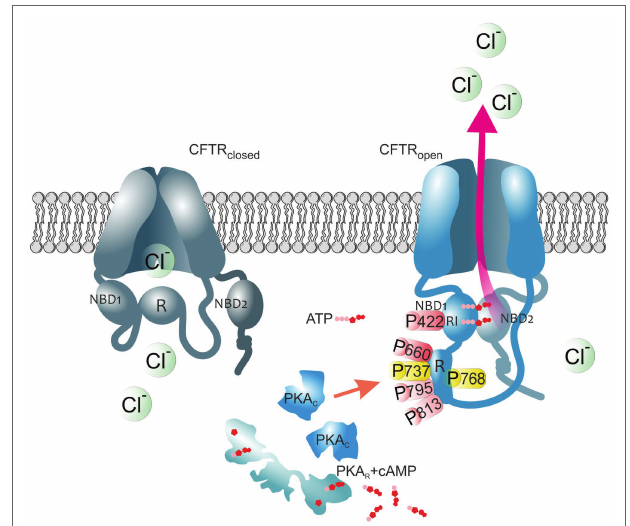
FIGURE 1 | The impact of PKA-mediated phosphorylation on CFTR channel. The cystic fibrosis transmembrane conductance regulator (CFTR) structure consists of two membrane spanning domains, two nucleotide-binding domains (NBD1 and NBD2), and the unique cytoplasmic regulatory (R) domain. Among these, the latter represents a critical site of channel regulation due to its enrichment in protein kinase A (PKA) consensus motifs, with multiple serines and threonines as phosphorylation targets. Moreover, there is an additional phosphorylation site in the regulatory insertion (RI) segment of NBD1. In the closed CFTR state (left channel), the NBD1 interacts with the R domain creating steric hindrances which prevent it from dimerization with NBD2. Upon PKA- dependent phosphorylation (right channel), large conformational changes occur that decrease this interaction leading to the release of the R region from its inhibitory position and allow NBDs dimerization, ultimately ATP binding and CFTR-mediated chloride secretion. Thus, the open probability of the channel is dependent on the access of PKA to the main phospho-sites (S422, S660, S737, S768, S795, and S813). Phospho-sites critical for CFTR channel activation are shown in red. Phosphoserines S737 and S768 are shown in yellow since they have been shown to either activate or inhibit CFTR gating. The role of the major PKA consensus sites in the regulation of CFTR function is detailed in Table 1